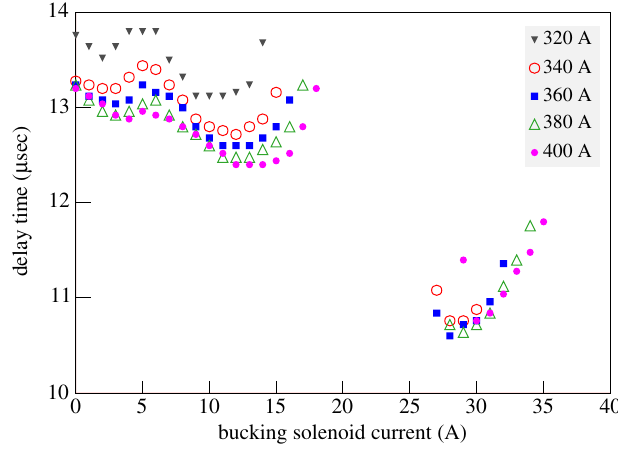
FIG. 11. (Color) Measurements of the delay time ( t the end of the rf pulse and the beginning of the multipacting spike as a function of bucking solenoid current ( I several main solenoid currents ( I tected at bucking solenoid currents between 18 and 26 A or higher than 35 A.